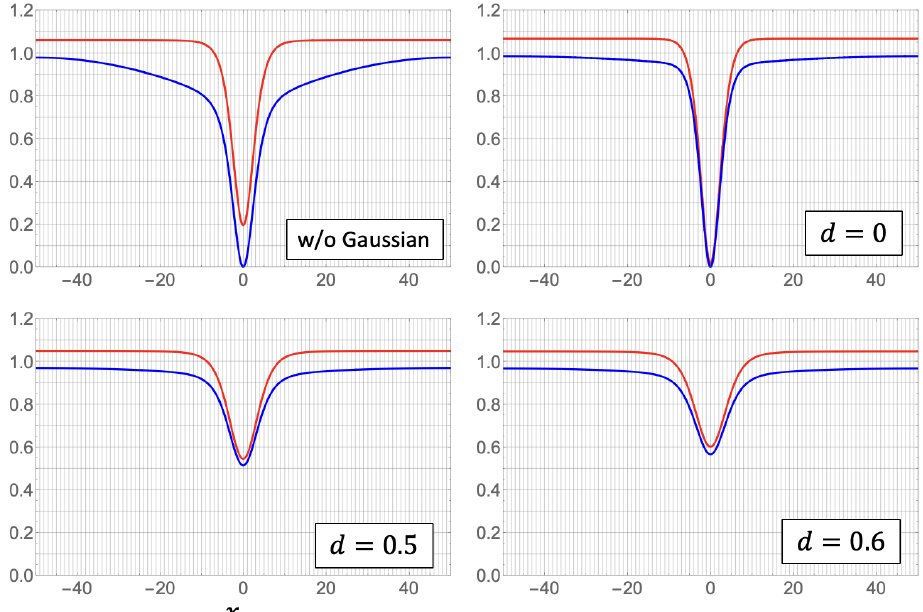
Figure 3. Density profiles (red curves) and the profiles of the square amplitude of the matrix element of the field operator between the quantum soliton states with N and N − 1 particles (blue curves) for N = L = 100 and the coupling constant c = 0.1. The vertical axis represents the local density. The profiles of the quantum soliton state without Gaussian weights are plotted in the upper left panel. In other panels, the profiles for the quantum soliton states with the ideal Gaussian weights are plotted for three values of target soliton depth d as d = 0,0.5, and 0.6, respectively. They correspond to the parameters of the Gaussian weights, ( P , σ 2 ) = ( π ,0.421637 ) , ( 0.18169 π ,0.149071 ) , and ( 0.124027 π ,0.106667 ) , respectively, through Equations (93) and